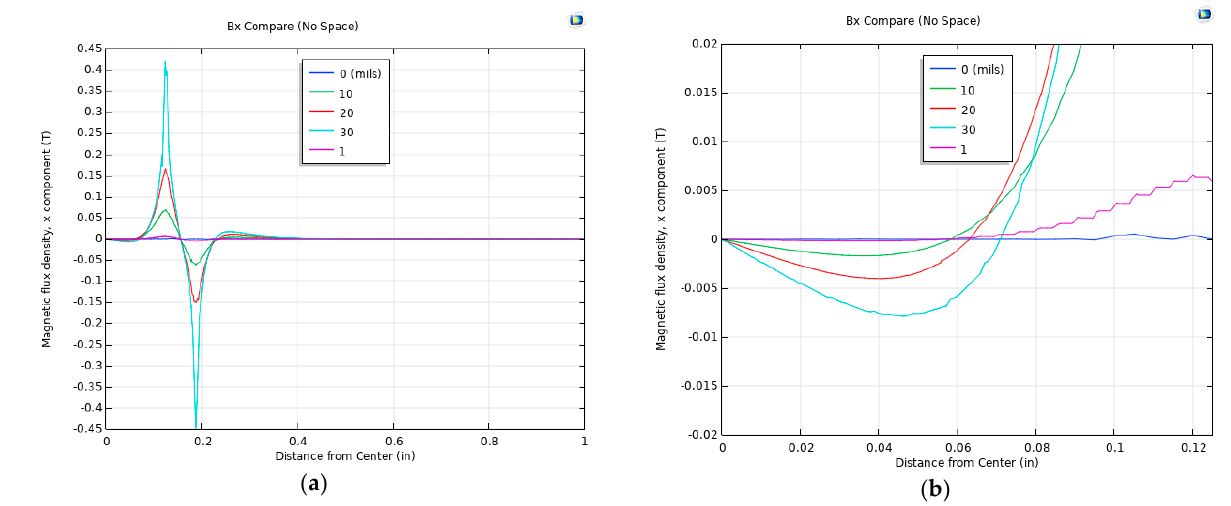
11 of 14 Figure 13. Far-field asymptotic behavior, 1/r 5 (blue broken line), and 1/r 3 (green broken line).